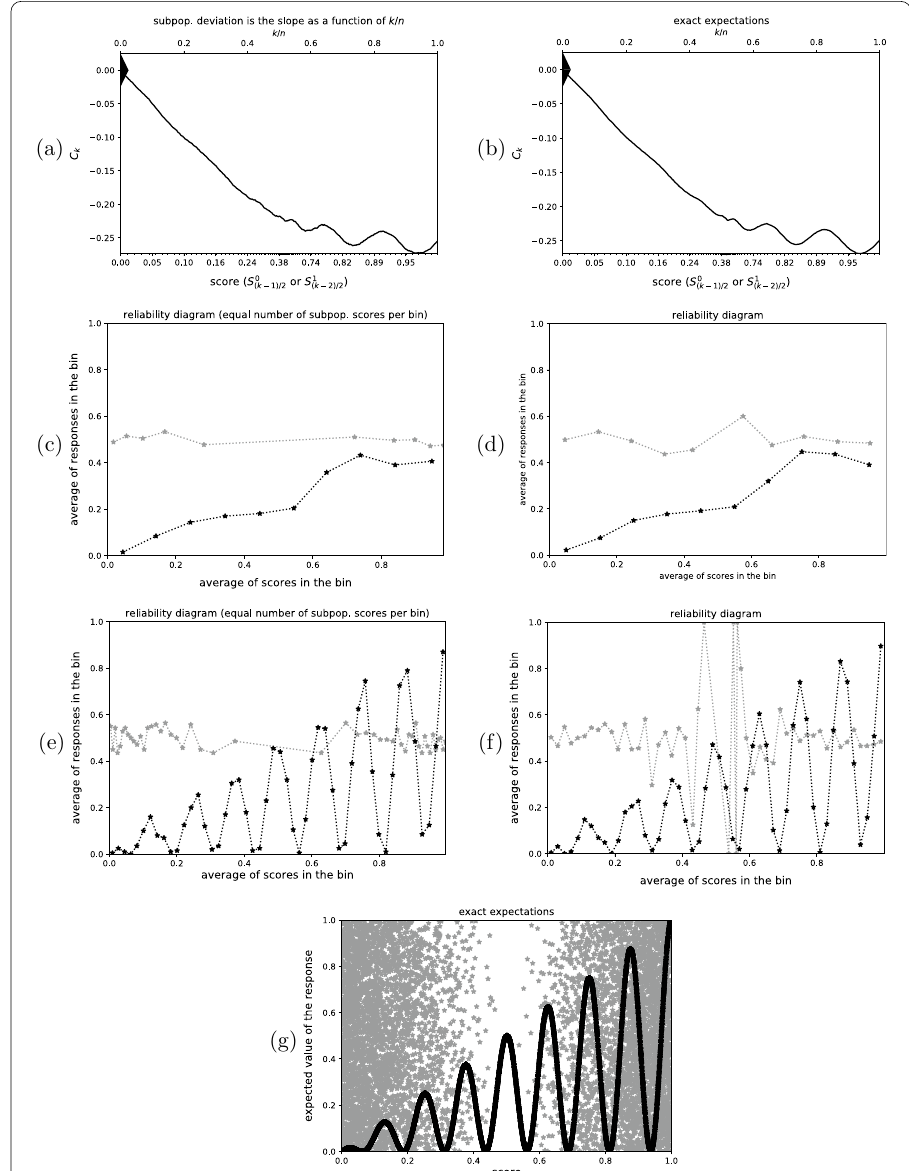
Fig. 5 n = 6637; Kuiper’s statistic is 0.2730 /σ = 22.24 , Kolmogorov’s and Smirnov’s is 0.2730 /σ = 22.24 ; the reliability diagrams with 10 bins each ( c and d ) smooth the black curve too much, while the reliability diagrams with 50 bins each ( e and f ) display overly noisy variations in the gray curve. The empirical cumulative graph ( a ) matches its ground-truth expectations ( b ) well, though the oscillations at low scores are a bit hard to discern in the cumulative graphs. The metrics of Kuiper and of Kolmogorov and Smirnov report profoundly statistically significant deviation, taking values many times larger than